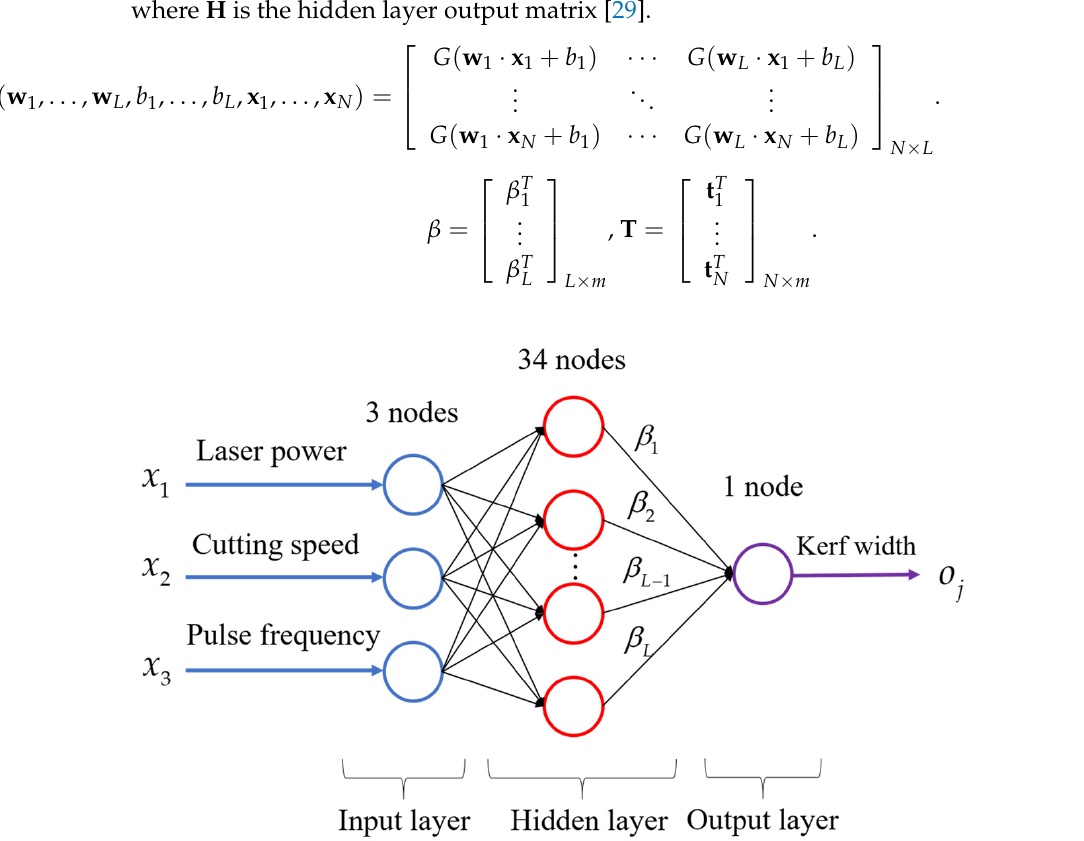
Figure 5. Structure of ELM model for kerf width prediction.